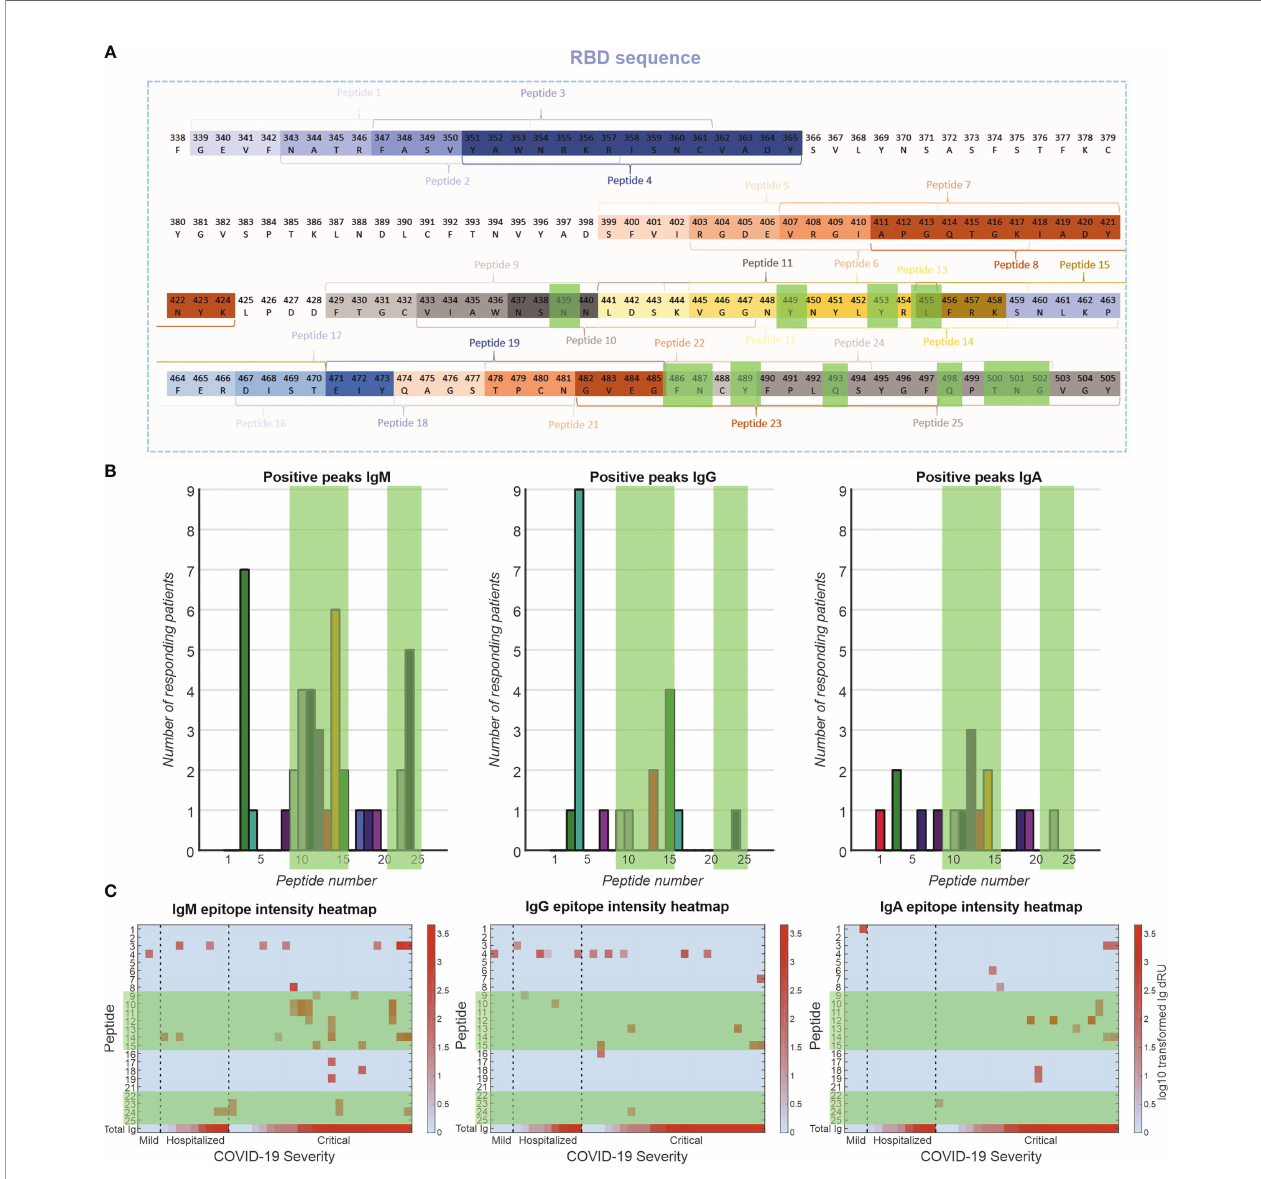
FIGURE 5 | Epitope mapping of antibody response toward RBD. (A) A peptide library of 24 peptides was created with four-amino-acid overlap between sequential peptides. These peptides are located at exposed moieties of the RBD and concentrated on the receptor-binding motif (RBM). The known binding motifs between the RBM and ACE2 receptor are highlighted in green. (B) Frequency of positive antibody responses toward speci fi c peptides IgM, IgG, and IgA. (C) Heatmap of epitope interaction intensity in responder patients. Patients are clustered based on severity and ordered based on total Ig response versus RBD. Heatmap color coding depicts log10 transformed Ig dRU